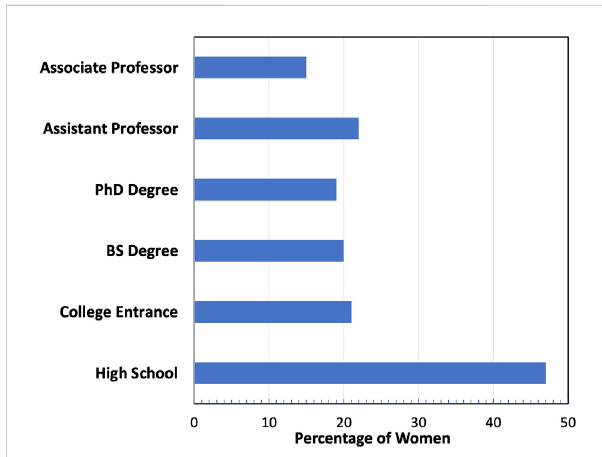
FIGURE 5 Percentage of participating physicists that are women at